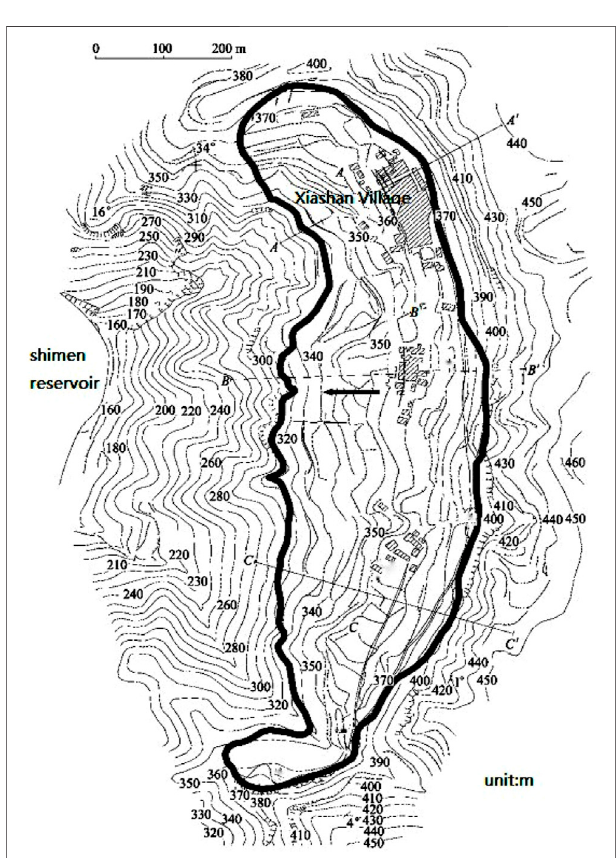
FIGURE 2 | Planar graph of Xiashan landslide.